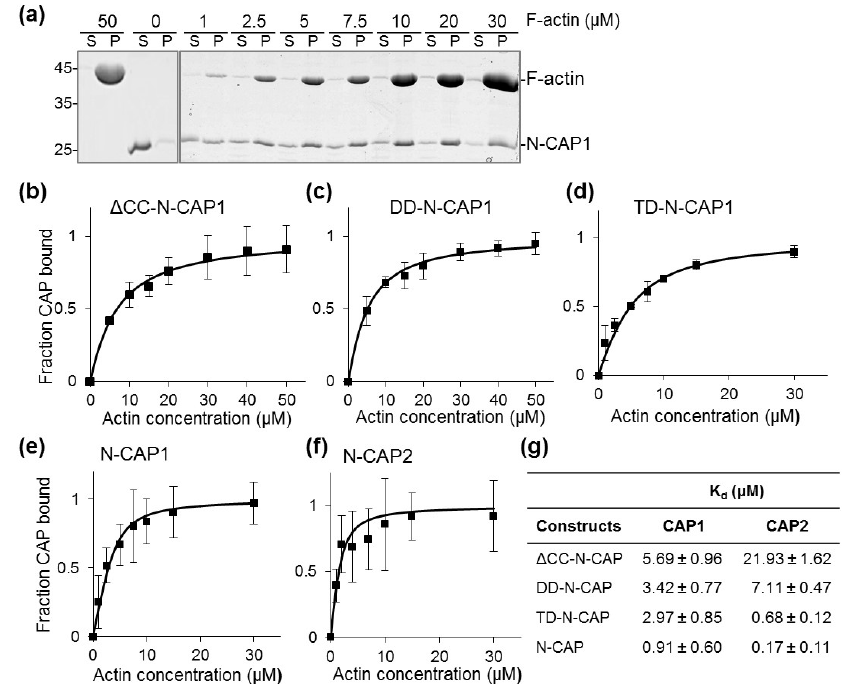
Figure 4. Comparison of F-actin binding affinities of human N-CAP constructs. CAP binding affinities to F-actin were analyzed by high-speed (300,000 × g ) cosedimentation: ( a ) representative sodium dodecyl sulfate polyacrylamide gel electrophoresis (SDS-PAGE) of supernatant (S) and pellet (P) fractions of N-CAP1 co-pelleted with F-actin (uncropped version of the gel is shown in Supplementary Figure S2); ( b – f ) binding curves with error bars representing the standard errors of the mean of three independent repetitions; ( g ) K d values determined by fitting the experimental data to the binding isotherm equation defined in the Section